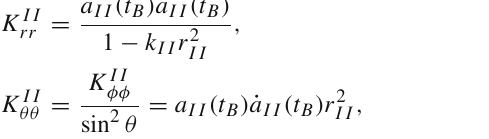
Fig. 3 The Penrose diagram for the described model in the case (a) contains four separate regions. Region I describes the collapsing OSD cloud matched to a vacuum Schwarzschild exterior, region III. Region II describes the expanding cloud which is matched to the collapsing one at the time of the bounce and to a different Schwarzschild exterior, region IV. The two Schwarzschild regions are causally disconnected as they are matched through a massive thin layer located at a constant radius inside the horizon. The dotted lines in region I and region II are apparent